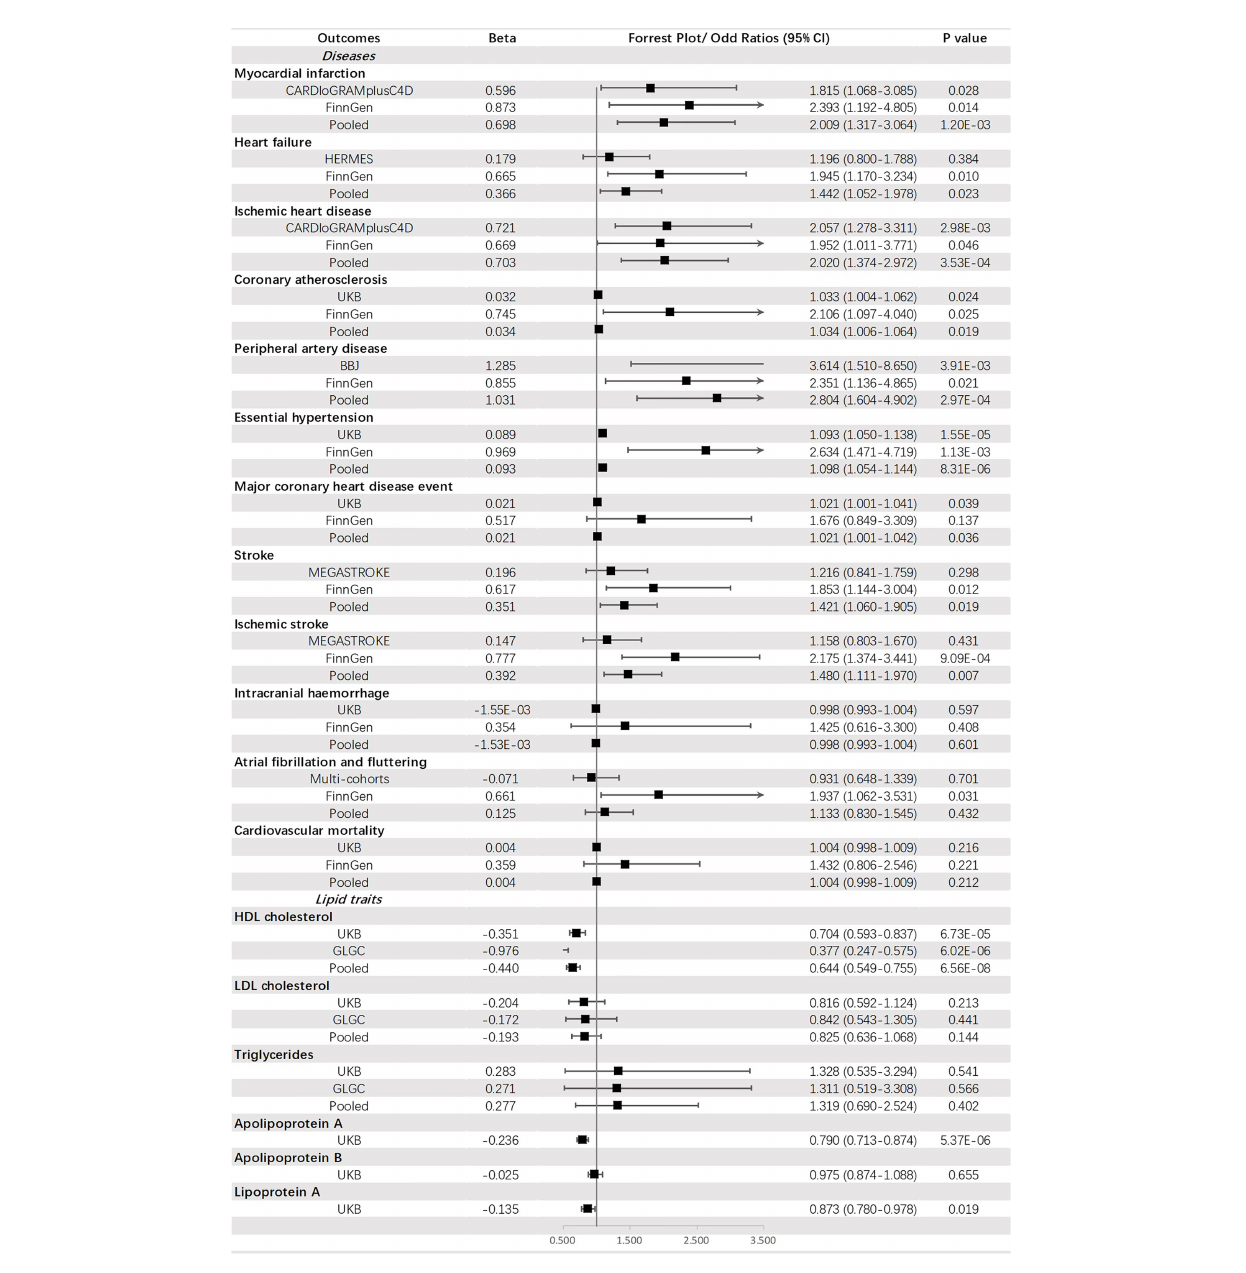
FIGURE 5 | The association between fasting insulin (mmol/mol) and